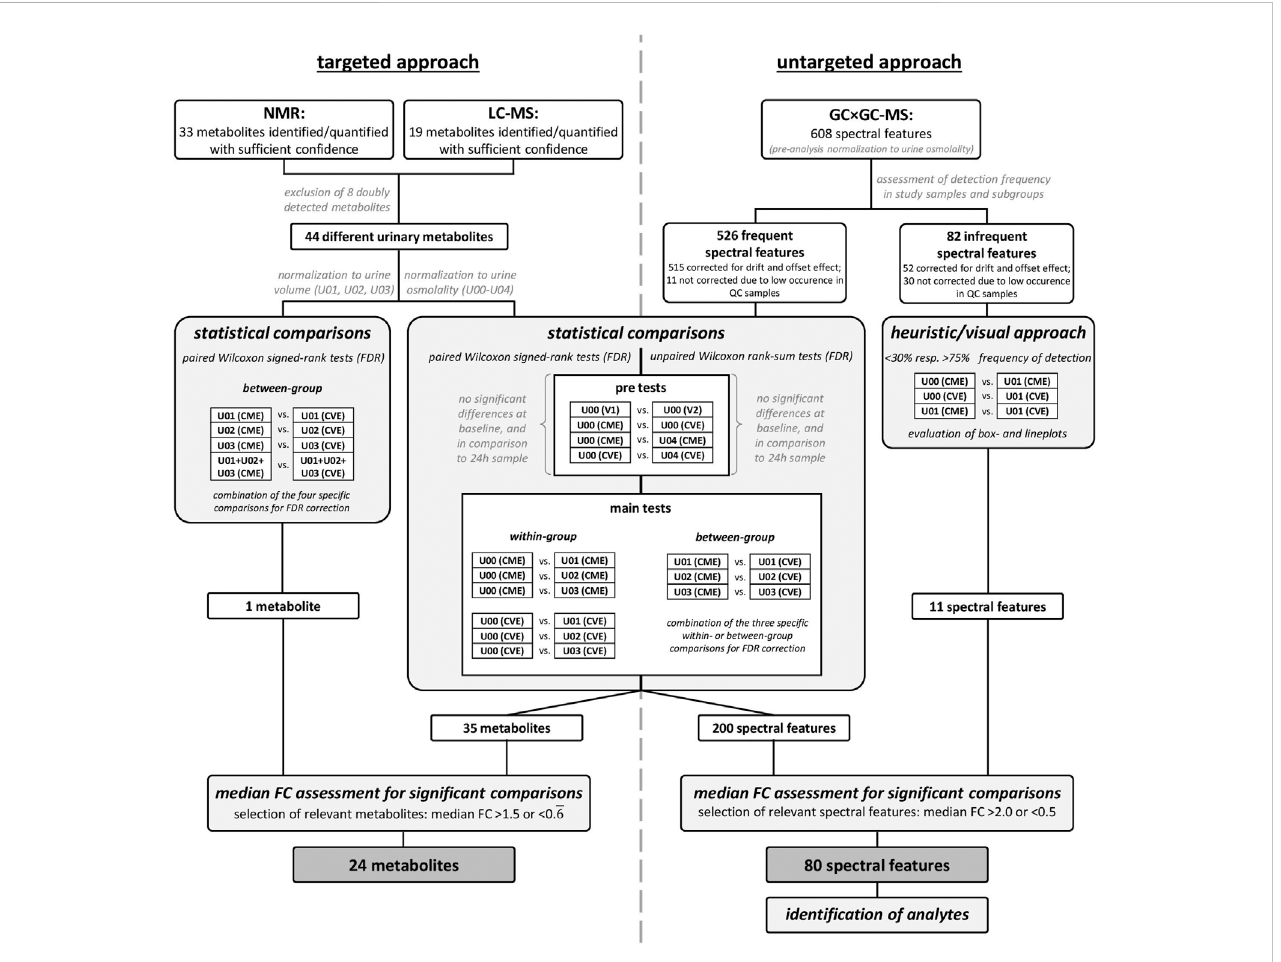
Work fl ow for metabolomics and statistical